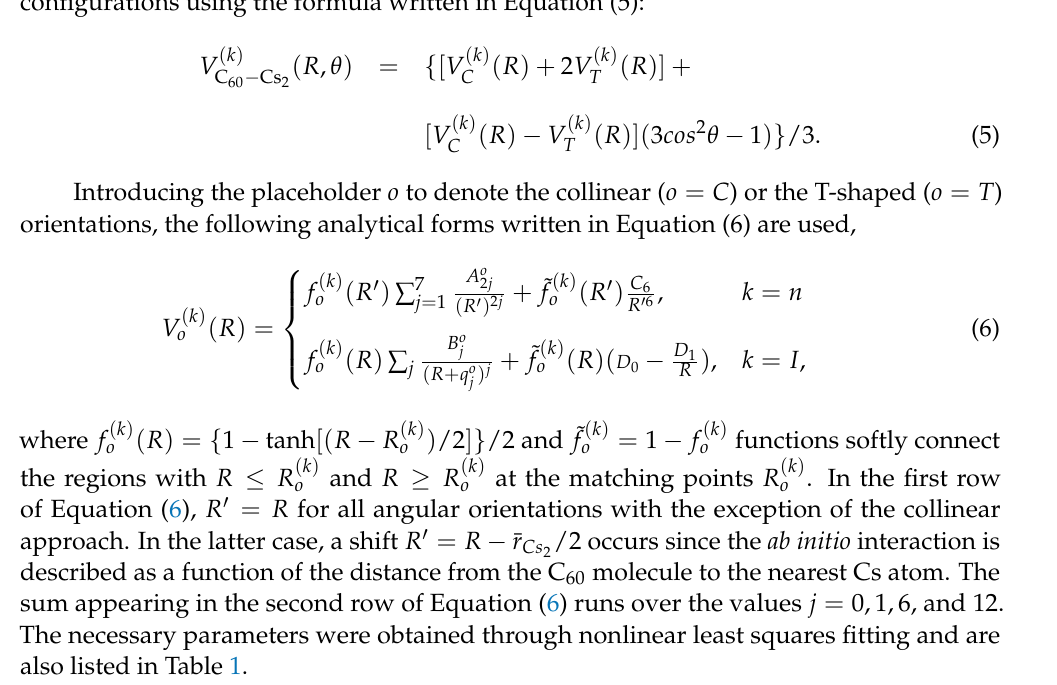
-C − interactions at collinear (C) and T-shaped 2 60